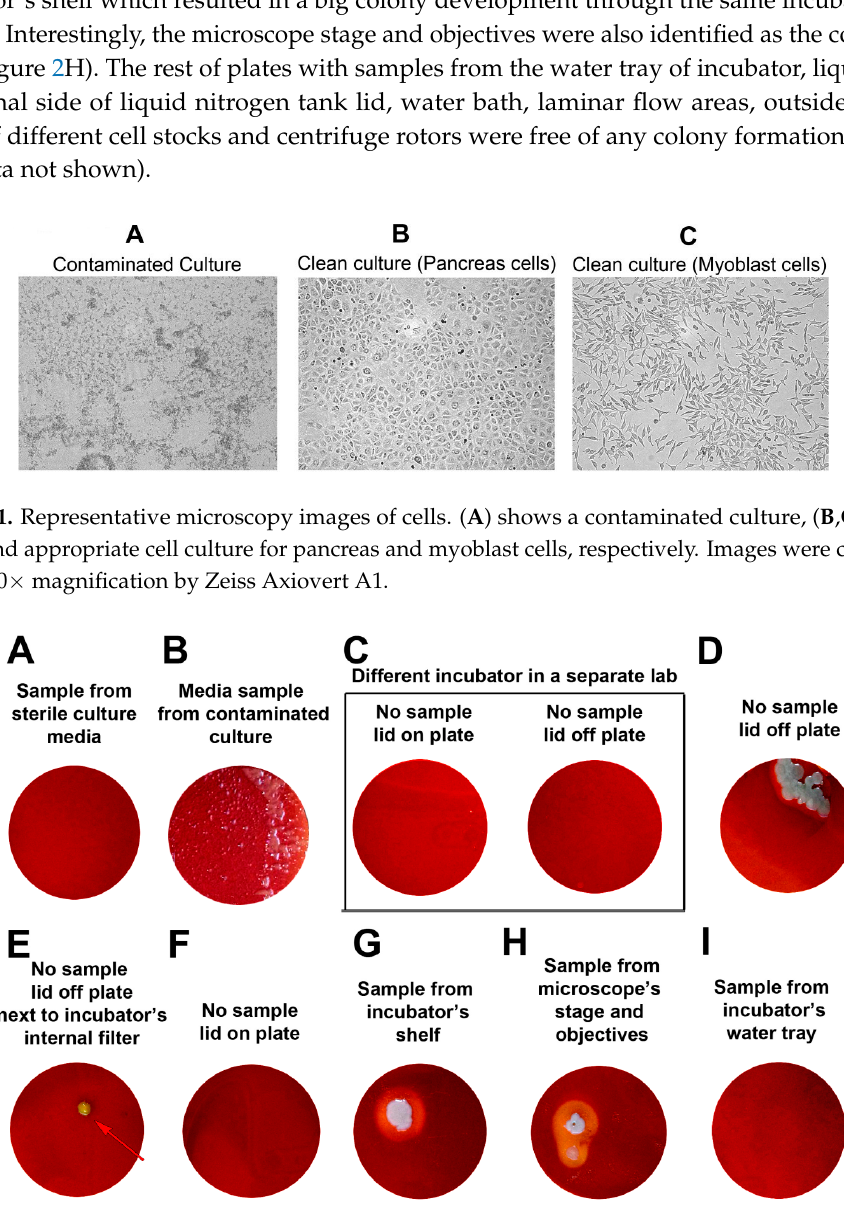
Figure 2. Representative blood agar plates with cultured samples from different sources of the laboratory. ( A , B ) show media control plates including negative (clean media) and positive control (contaminated media) samples, respectively. ( C ) shows control plates with or without lids incubated in a different laboratory providing counterparts of ( D – F ). ( G – I ) show cultures from the shelves of the incubator, microscope stage/objectives and the water tray of the incubator, respectively.